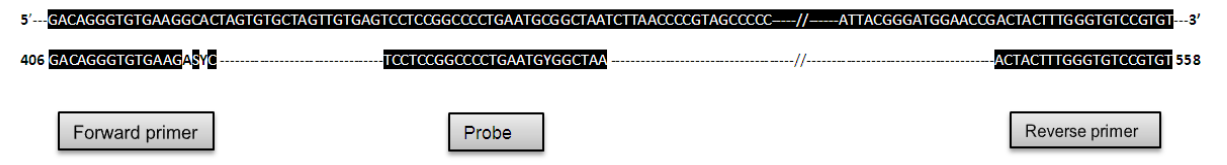
Figure 4. Alignment of primers and probe of the RV diagnostic PCR with the RV-C54 virus